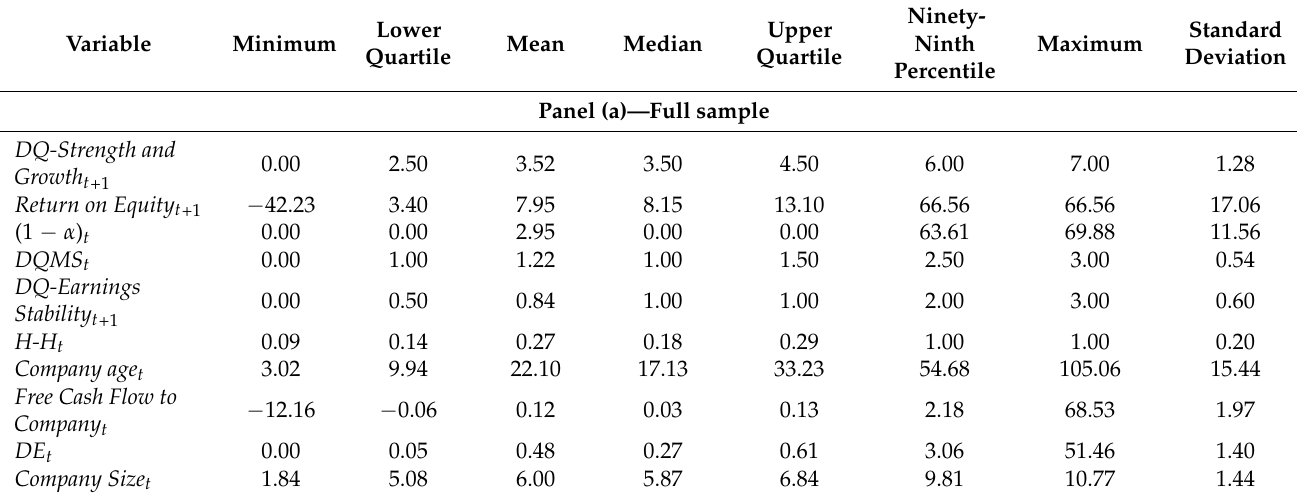
Table 1. Univariate statistics—Continuous